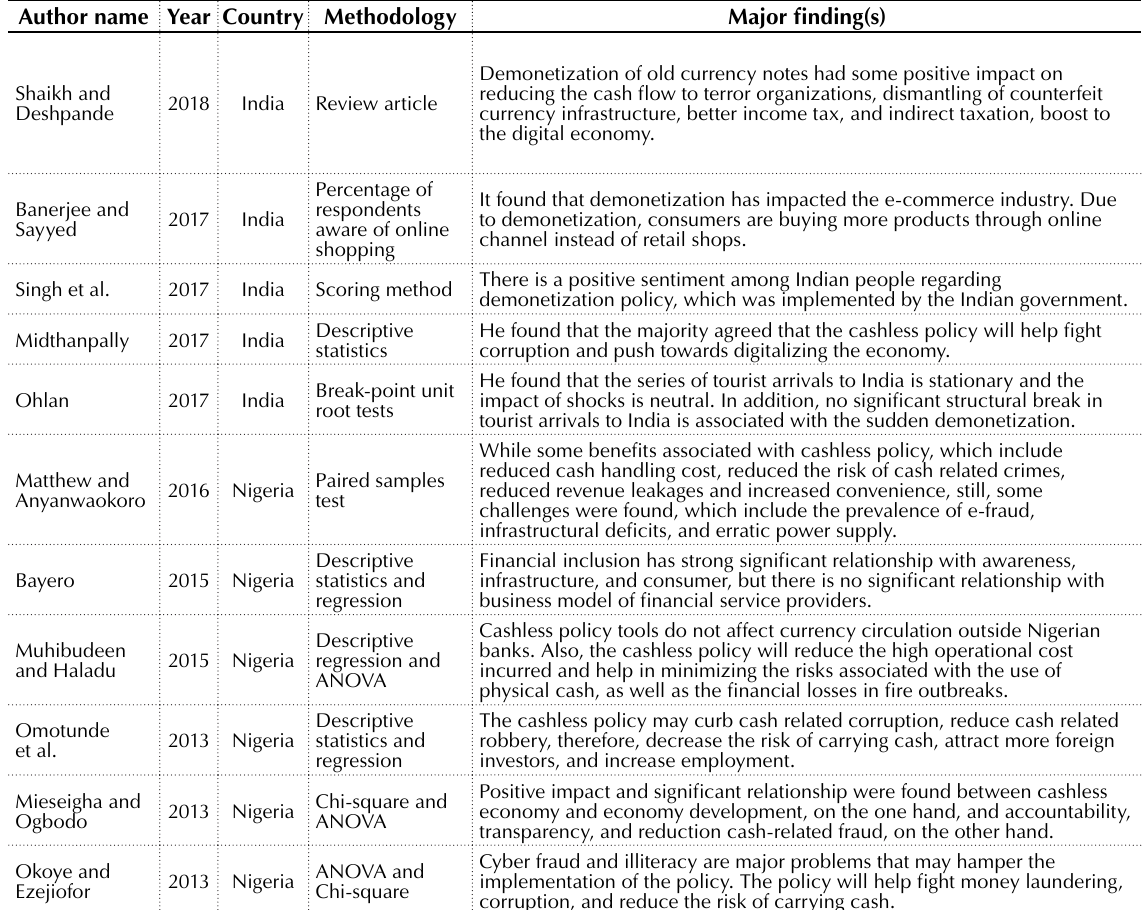
Table 1. Summary of empirical studies on demonetization – performance